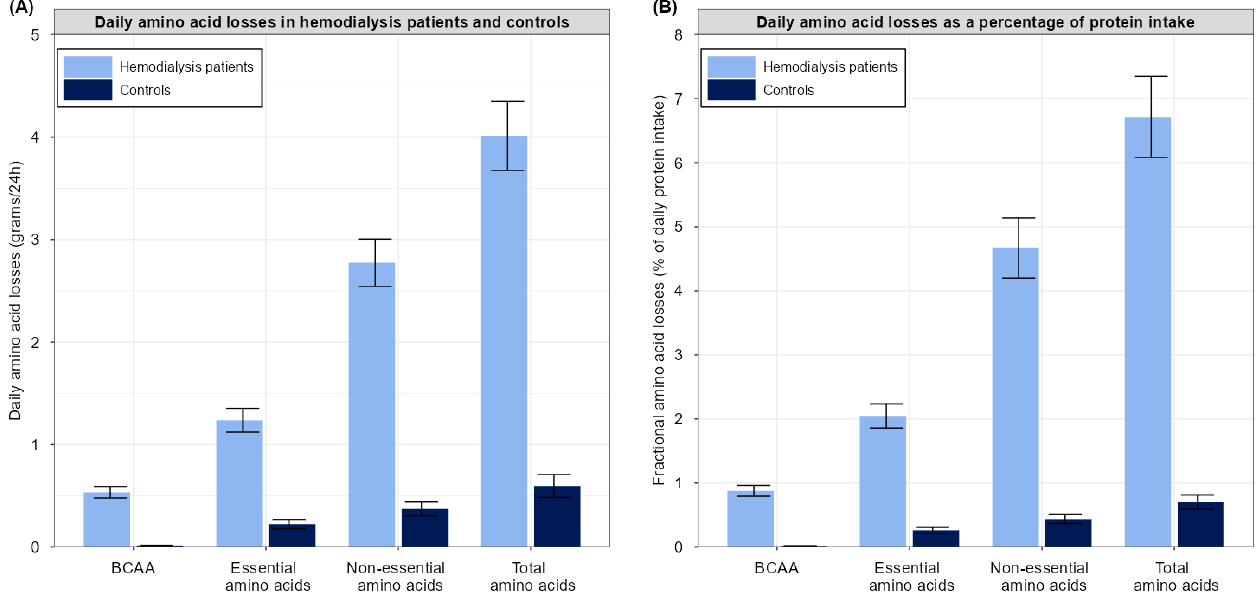
Figure 1. Comparison of absolute daily amino acid losses ( A ) and daily amino acid losses expressed as a percentage of daily protein intake ( B ) in hemodialysis patients and controls. Error bars refer to lower and upper Gaussian confidence limits based on the t-distribution. Abbreviations: BCAA: Branched chain amino acid.